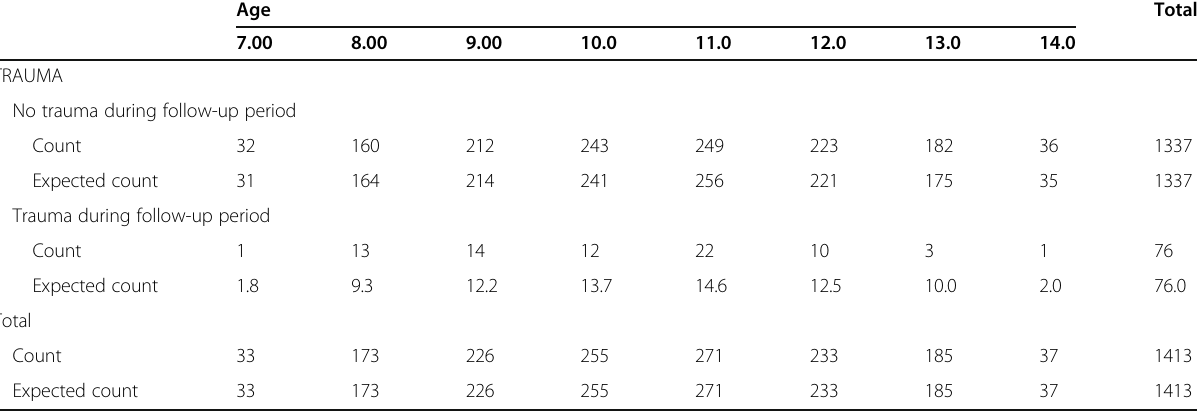
Table 1 Number of injuries, according to age